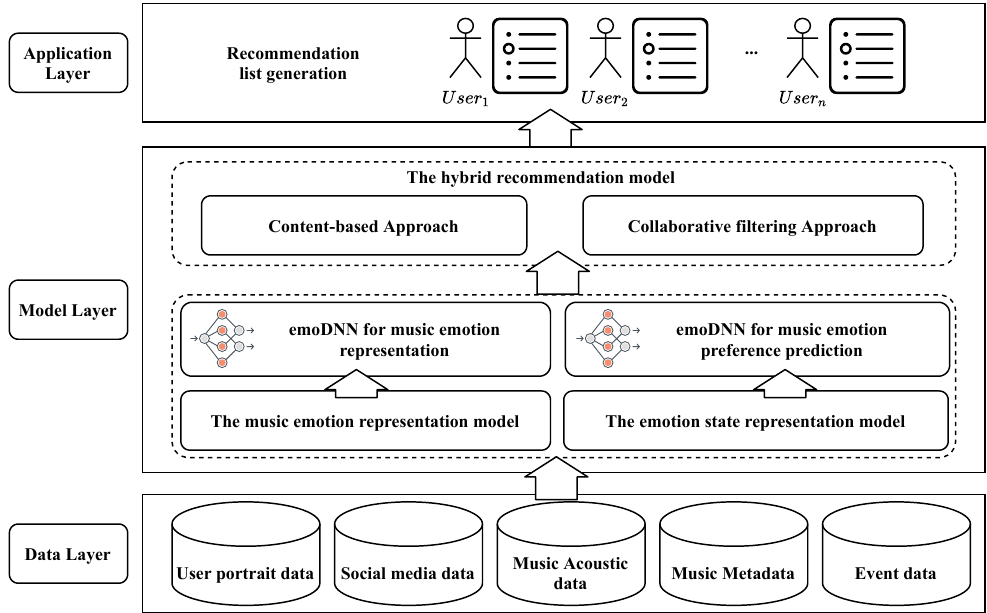
Figure 1. The general architecture of